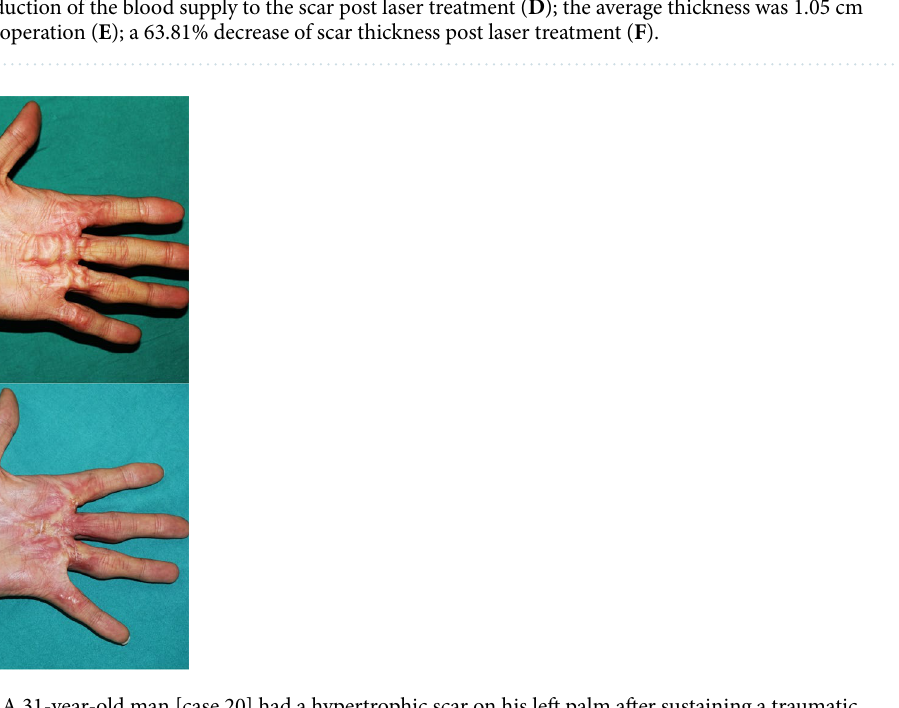
Figure 2. A 31-year-old man [case 20] had a hypertrophic scar on his left palm after sustaining a traumatic injury over 1.5-year ago ( A ); post one session of laser treatment ( B